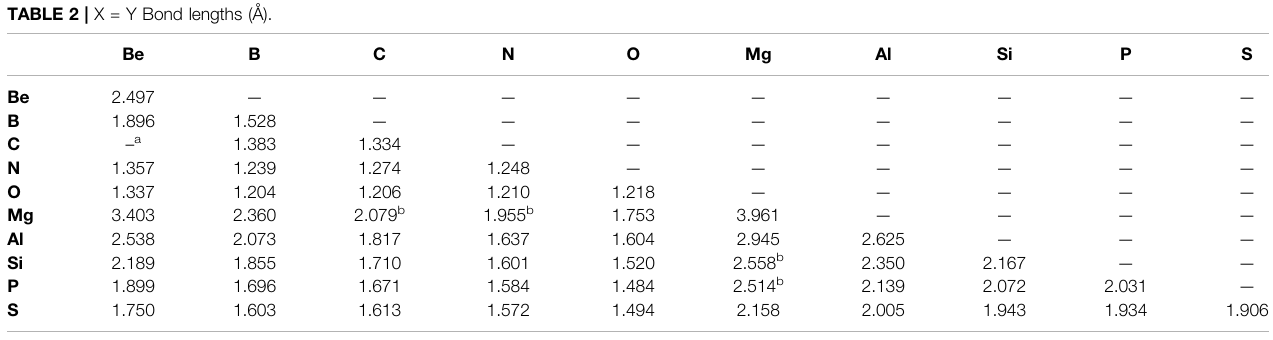
TABLE 2 | X (cid:1) Y Bond lengths